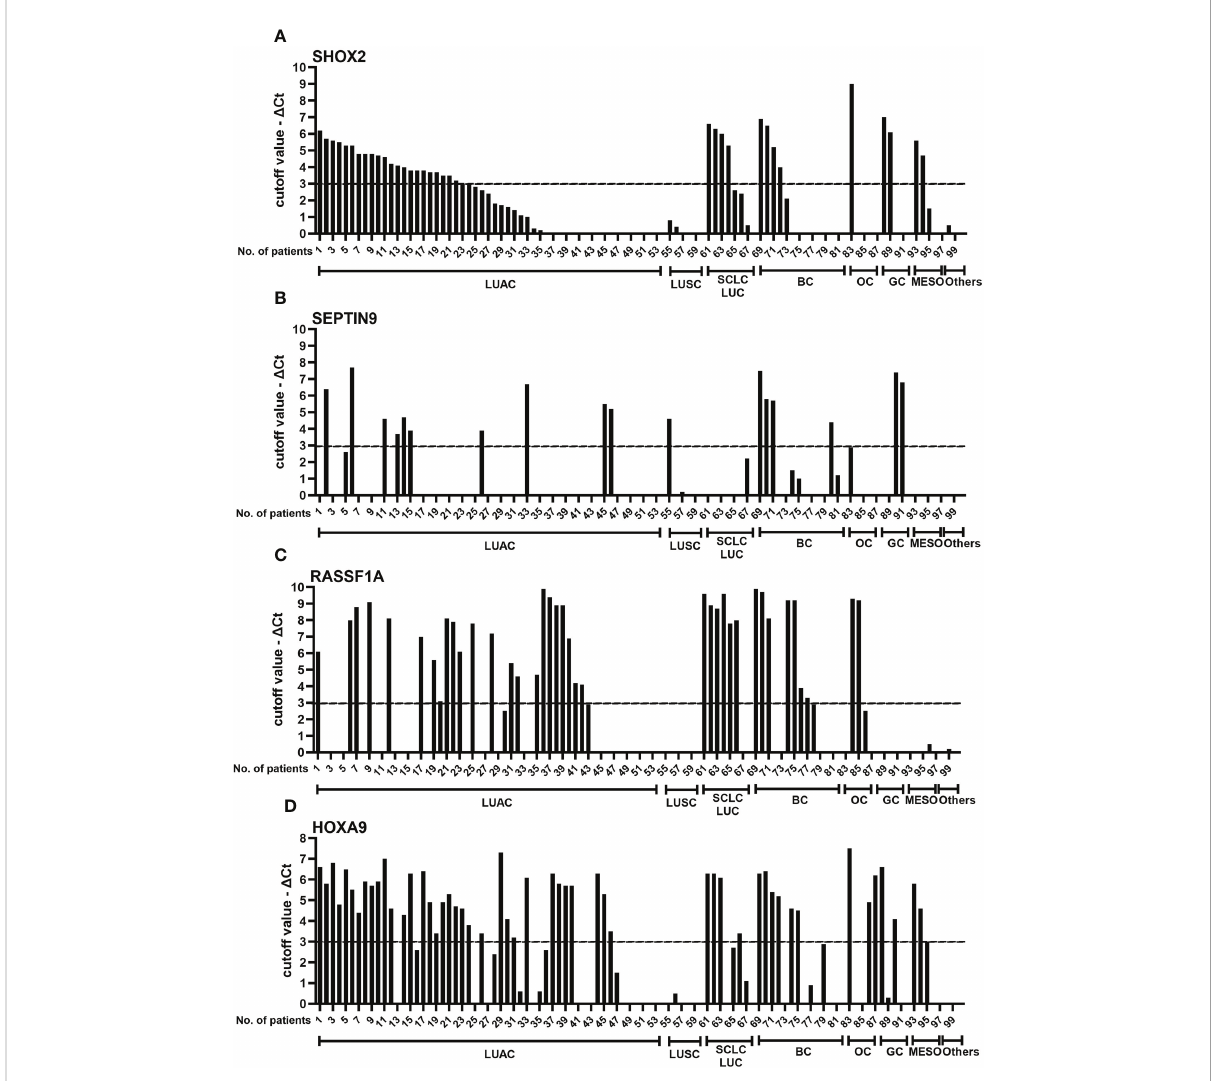
FIGURE 4 Comparison of SHOX2 (A) , SEPTIN9 (B) , RASSF1A (C) , and HOXA9 (D) methylation levels in individual pleural effusion specimens. To display the change in methylation levels more intuitively, the methylation level of an individual gene was calculated as the X value, which was calculated as 9- D CtSHOX2, 12- D CtRASSF1A, 8- D CtHOXA9 and 9- D CtSEPT9. Then, the methylation levels of SHOX2, RASSF1A, HOXA9 and SEPTIN9 were categorized as strongly methylated (X>3), mildly methylated (0<X ≤ 3) and nonmethylated (X = 0). LUAC, lung adenocarcinoma; LUSC, lung squamous carcinoma; SCLC, small cell lung carcinoma; BC, breast cancer; OC, ovarian carcinoma; GC, gastrointestinal cancer; MESO, malignant mesothelioma; SHOX2, short stature homeobox gene two; RASSF1A, RAS association domain family 1, isoform A; HOXA9, homeobox A9; SEPTIN9, Septin